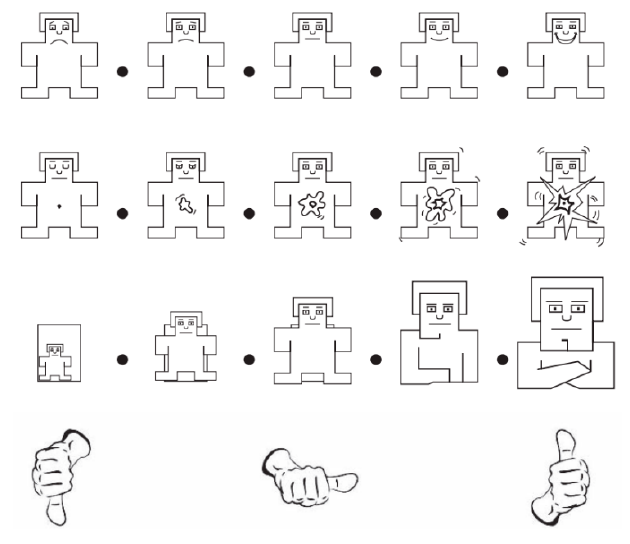
Figure 4. The self–assessment scales.